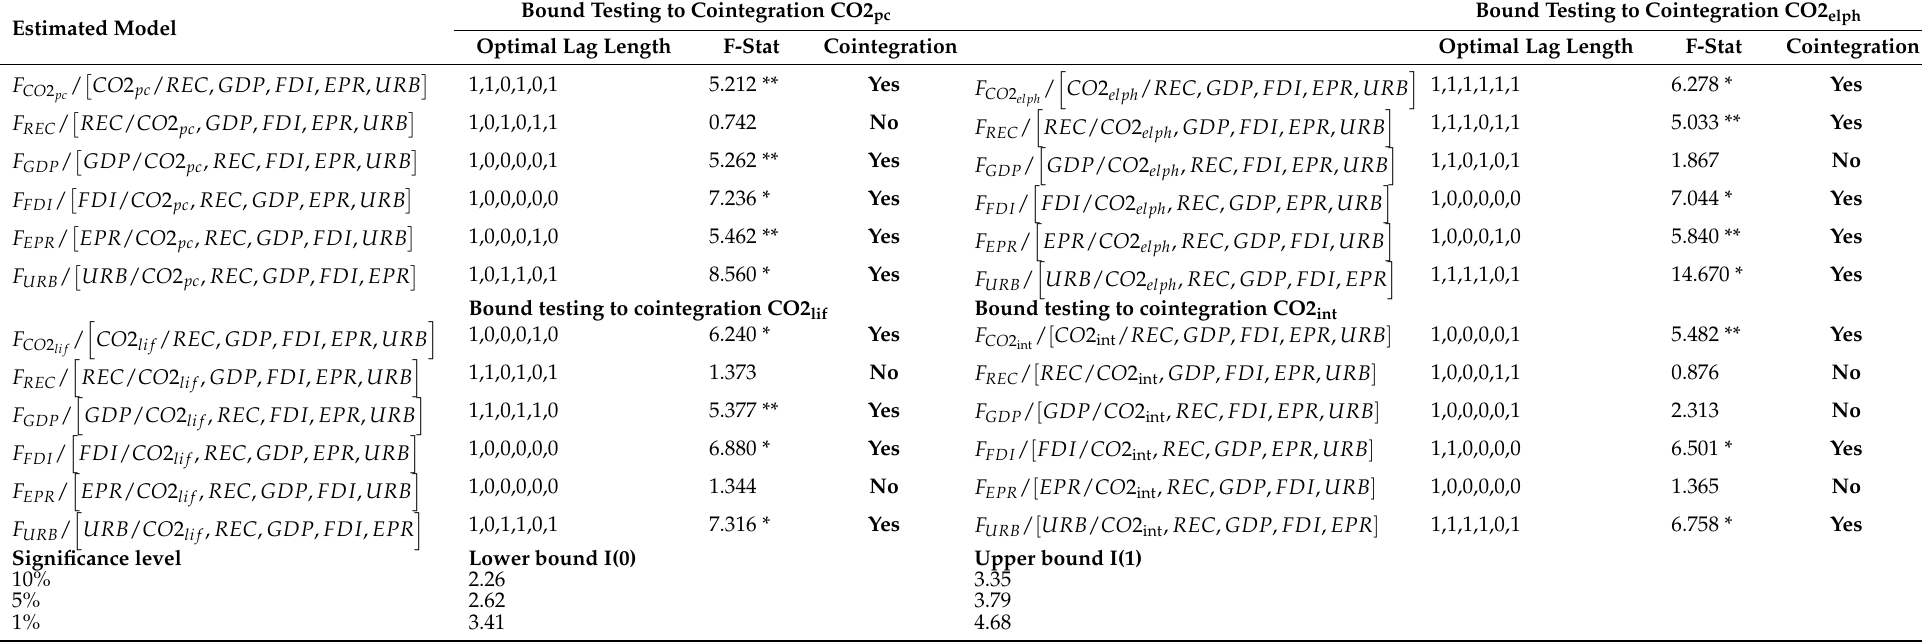
Table 5. ARDL Bound Test